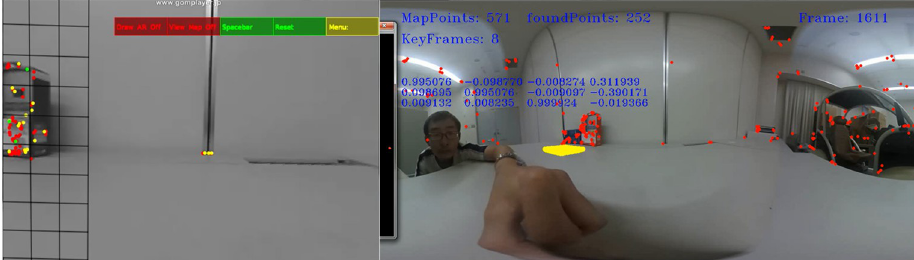
Figure 9. At the same position, PTAM fails to track as fewer feature points visible, while full-view SLAM tracks well.